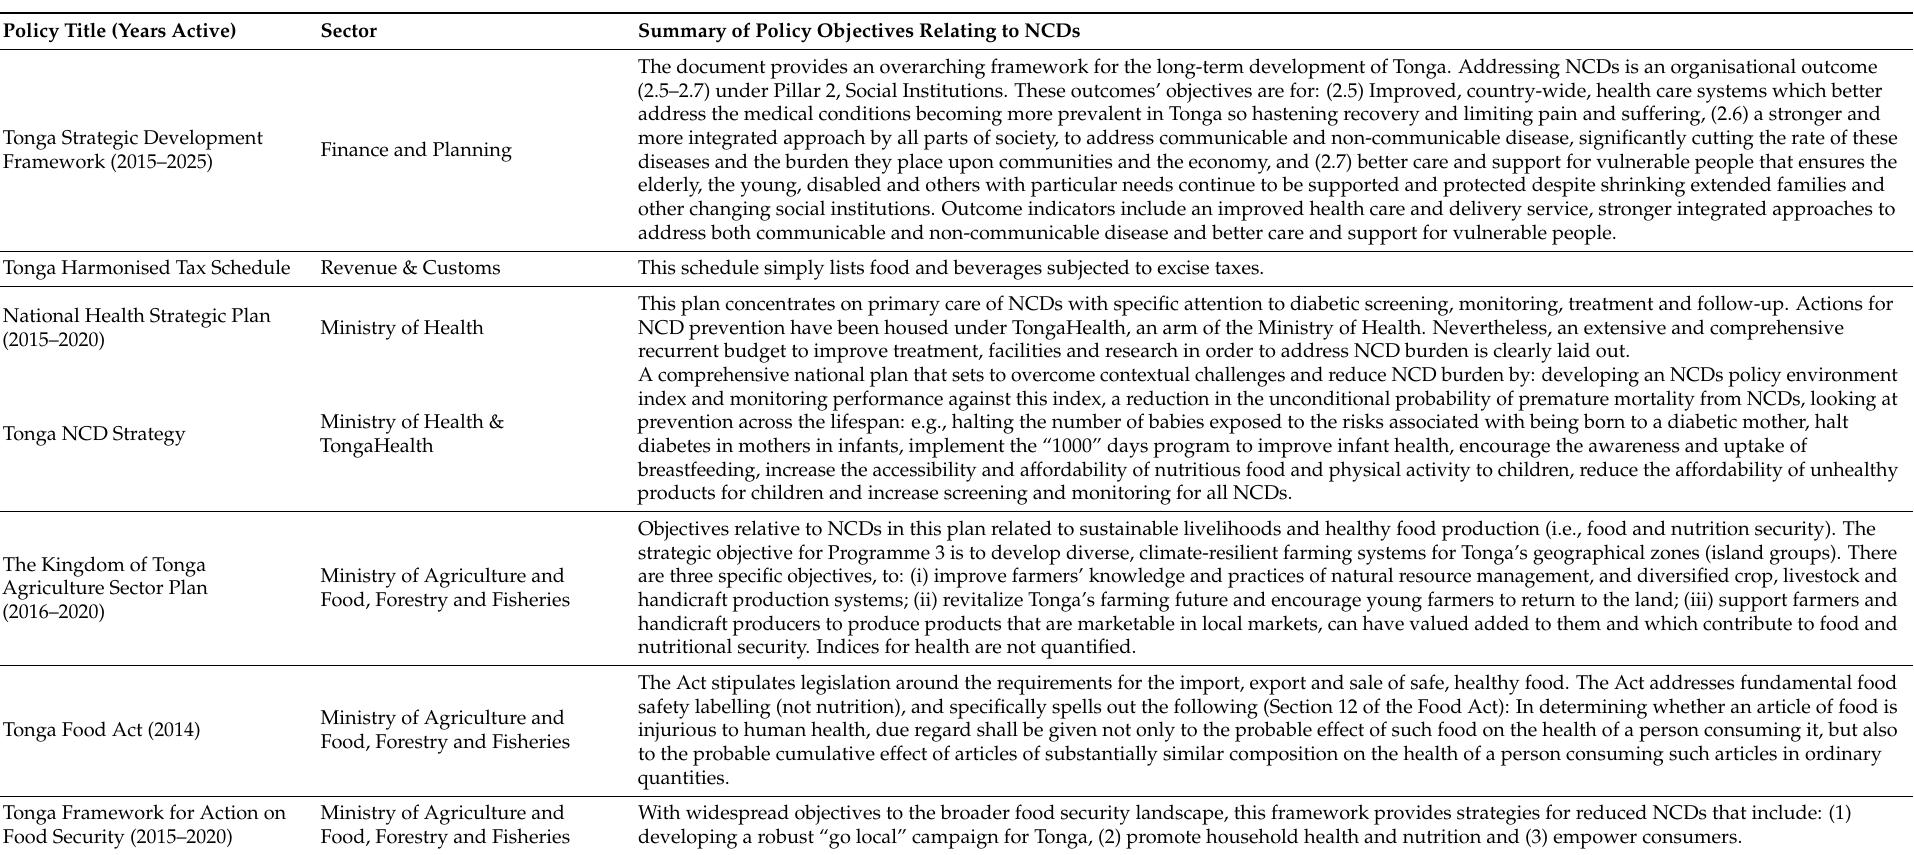
Table A2. Policies Identified Relating to NCD Prevention Actions in